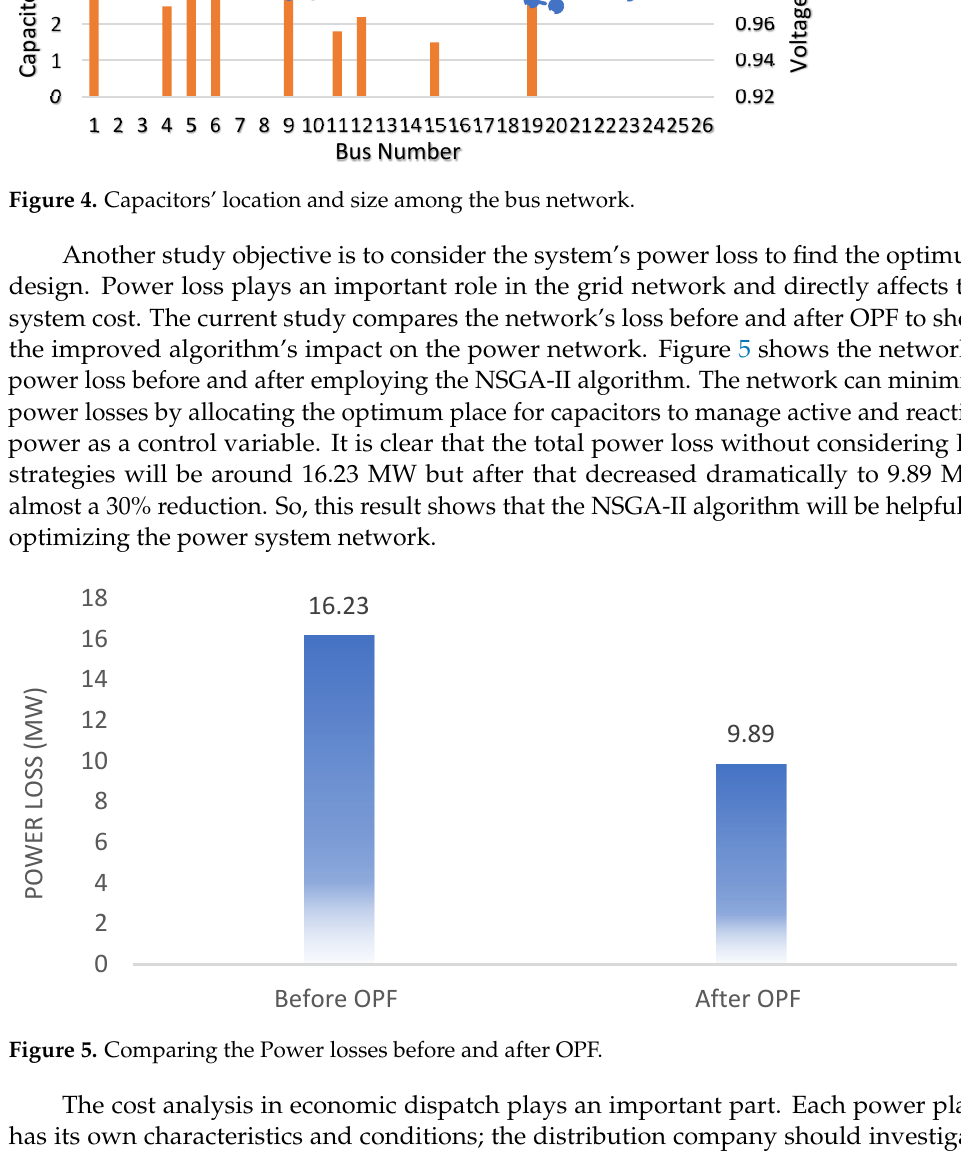
Figure 4. Capacitors’ location and size among the bus network.